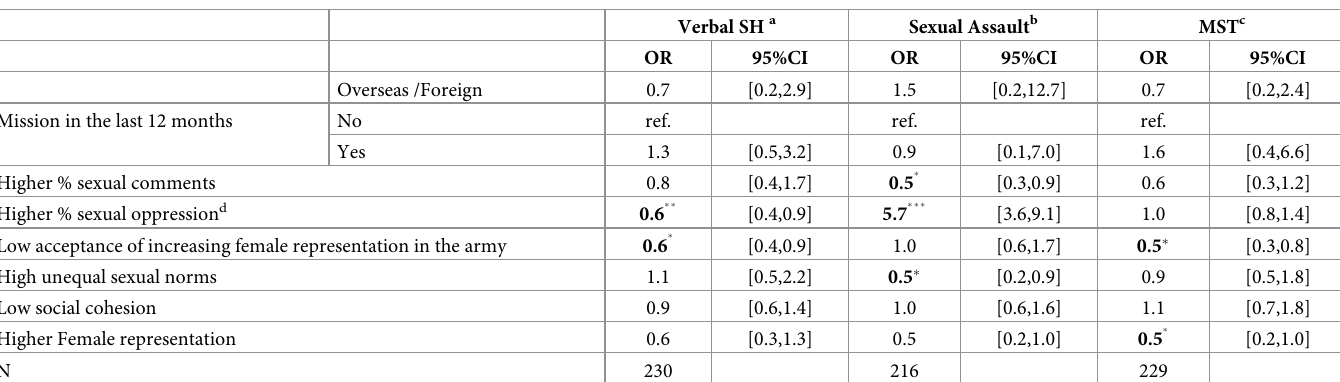
Table 4a: a Verbal SH = repeated sexual comments or repeated unwanted verbal sexual attention b sexual assault = touching, attempted or forced sex including with object or finger c . MST includes all sexual stressors d sexual oppression = repeated unwanted verbal sexual attention, sexual coercion or sexual assault Exponentiated coefficients; 95% confidence intervals in brackets; � p < 0.05, �� p < 0.01, ��� p < 0.001 Table 4b: a Verbal SH includes repeated sexual comments or repeated unwanted verbal sexual attention b sexual assault includes touching, attempted or forced sex including with object or finger c MST includes all sexual stressors d sexual oppression = repeated unwanted verbal sexual attention, sexual coercion or sexual assault Exponentiated coefficients; 95% confidence intervals in brackets; � p < 0.05, �� p < 0.01, ��� p < 0.00.